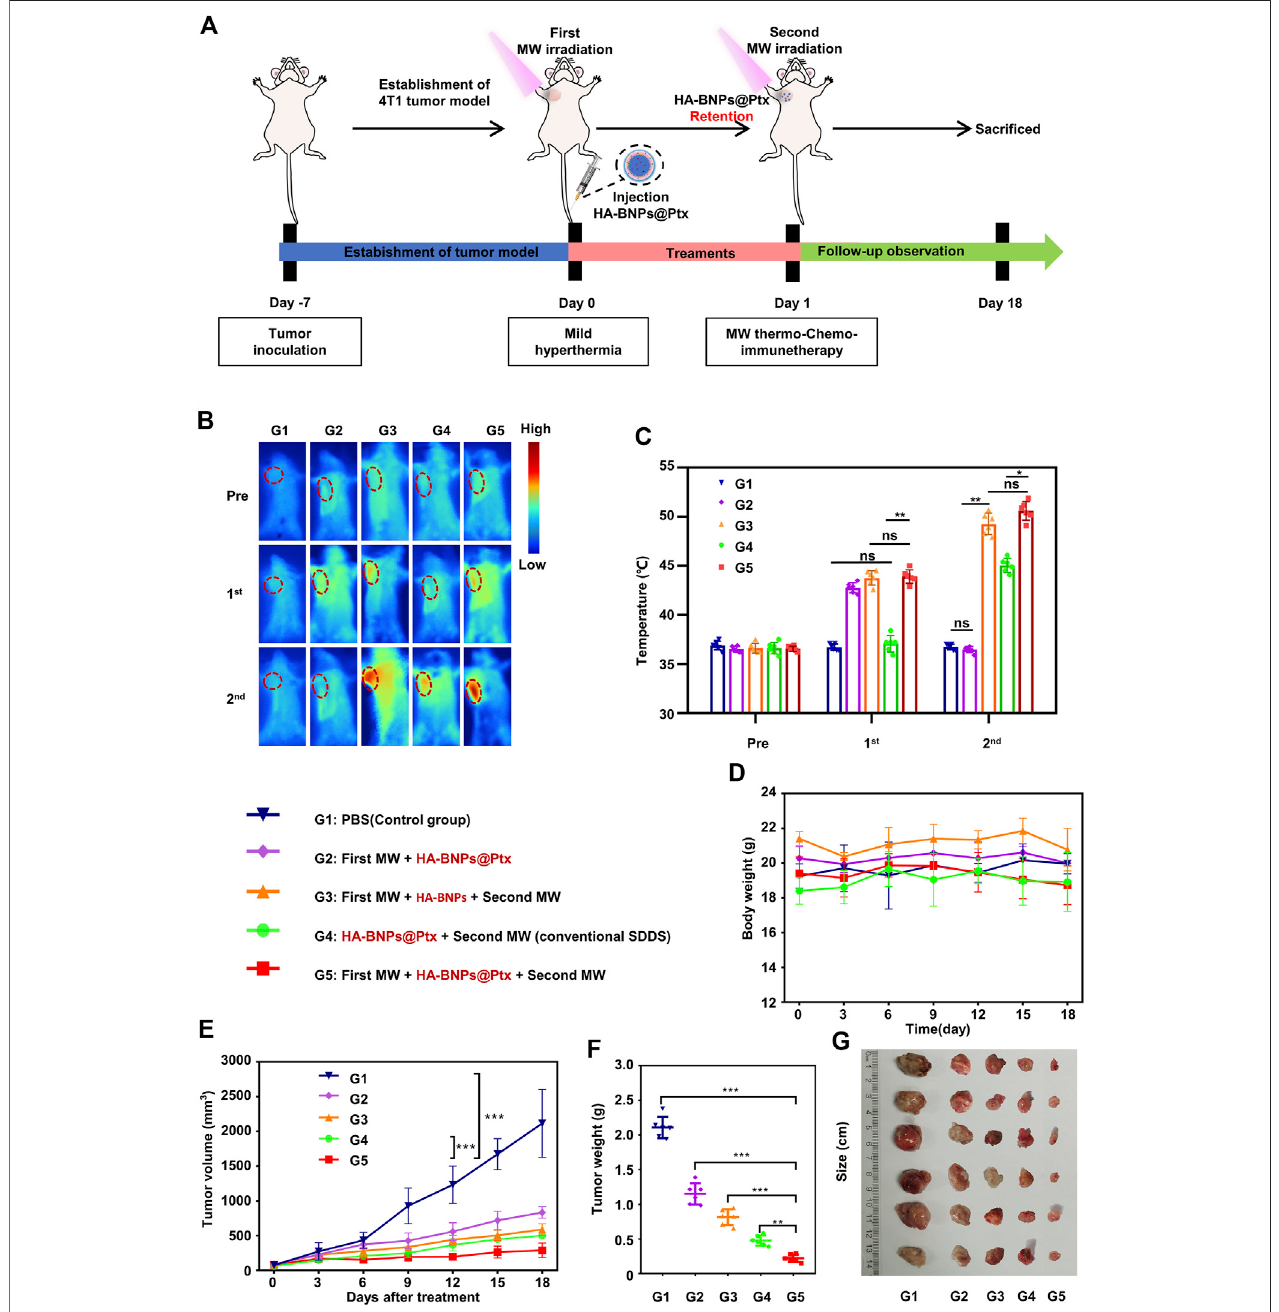
FIGURE 7 | In vivo study of the antitumor effect of synergistic cascade strategy (double hyperthermia + nanomedicine). (A) Schematic illustration of the treatment process of 4T1 breast tumor-bearing mice by synergistic cascade strategy. (B) Representative IR thermal images of 4T1 tumor-bearing mice treated with different conditions.MWirradiationwasperformedat0.8 Wcm − 2 for4 min. (C) Changesintumortemperaturebeforeandafter fi rstandsecondmicrowaveexposurefordifferent treatment mice groups (G1 – G5). (D, E) Body weight tumor growth of mice after SCS treatment, evaluated every 3 days. (F, G) Changes in tumor volume and representative photograph of excised tumor of the 4T1 breast tumor-bearing mice 18 days after the treatment (G1 – G5). The data are presented as mean ± SD ( n (cid:2) 6, ns, not signi fi cant; ** p < 0.01, *** p < 0.001).